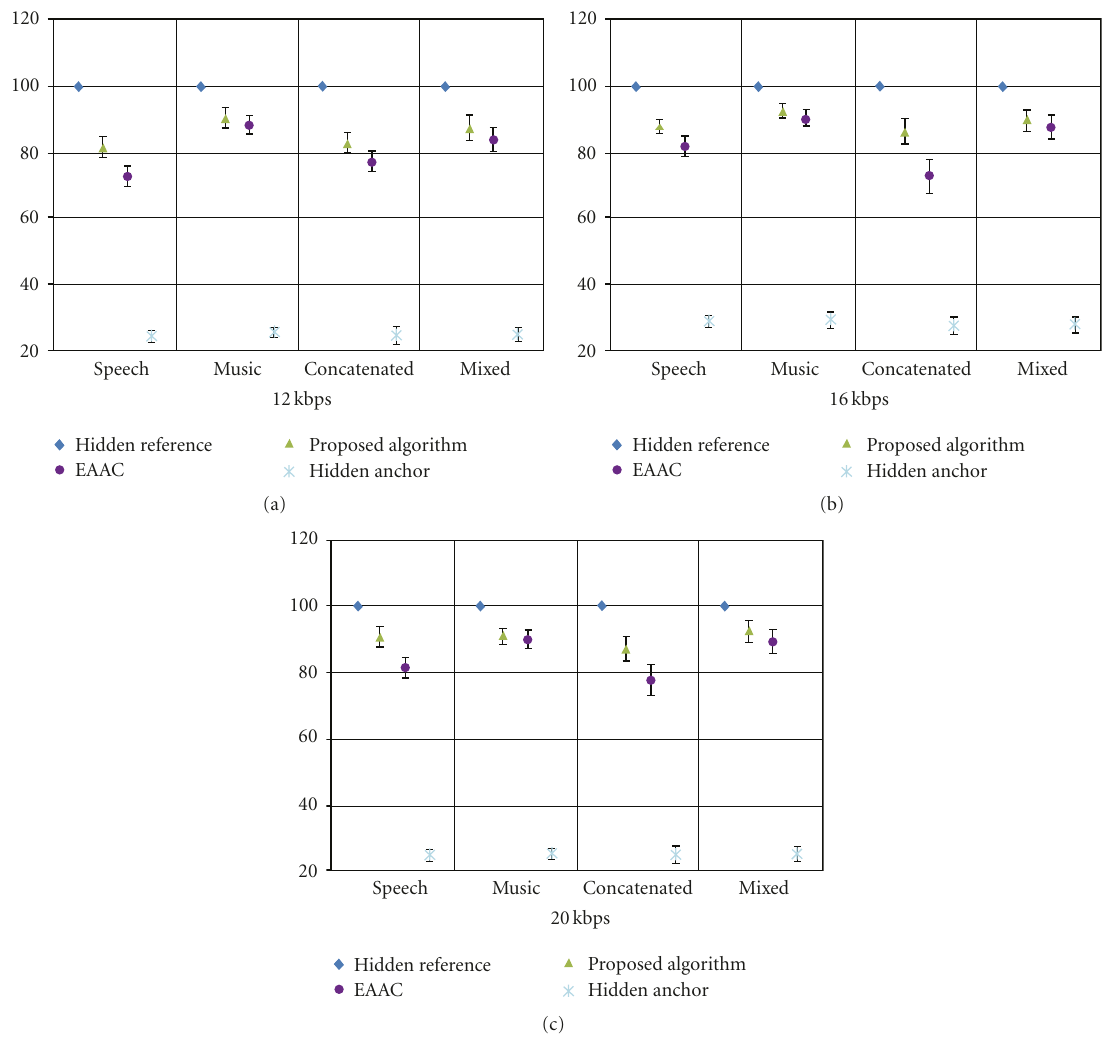
Figure 11: Results of MUSHRA test at (a) 12, (b) 16, and (c) 20